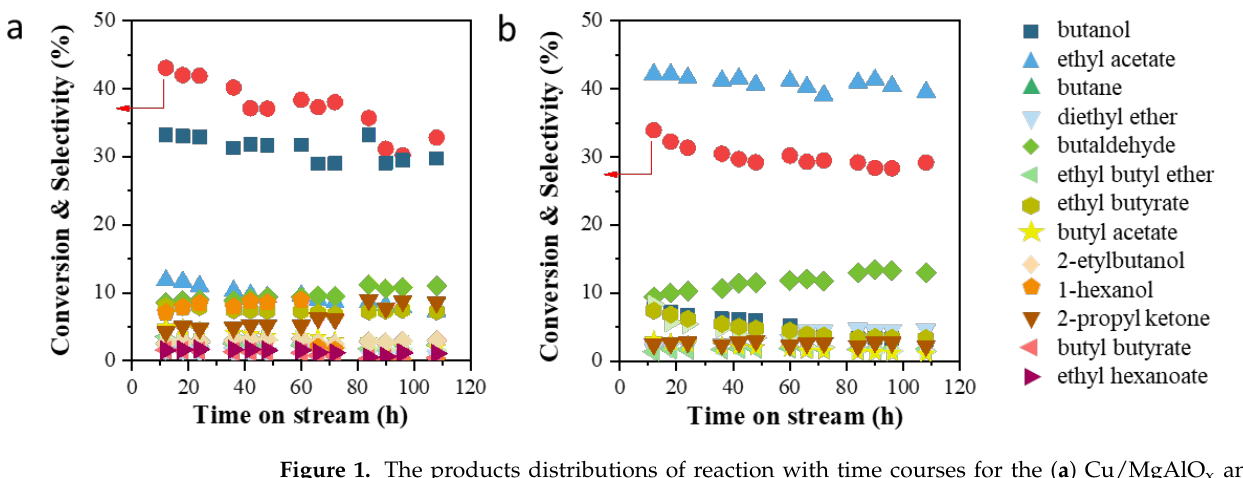
Figure 1. The products distributions of reaction with time courses for the ( a ) Cu/MgAlO x and ( b ) Cu/ZnAlO x catalysts. Reaction conditions: amounts of catalyst: 1 g; pressure of N 2 : 2 MPa; temperature: 553K; GHSV: 692 h −1 , LHSV: 4.8 h −1 .